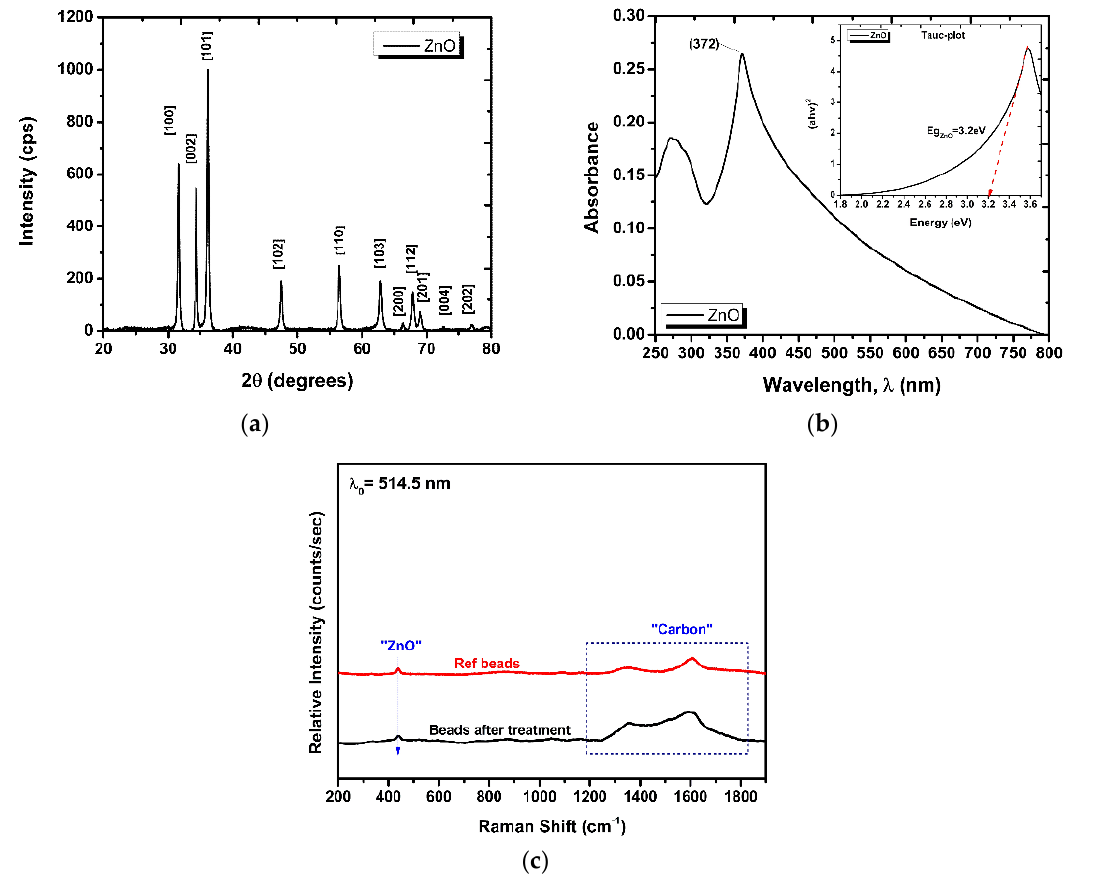
Figure 6. ( a ) XRD pattern of ZnO powder. ( b ) UV-Vis spectrum of a suspension of ZnO nanoparticles with the application of Tauc-plot method (inset). ( c ) Raman spectra of ZnO-coated balls.